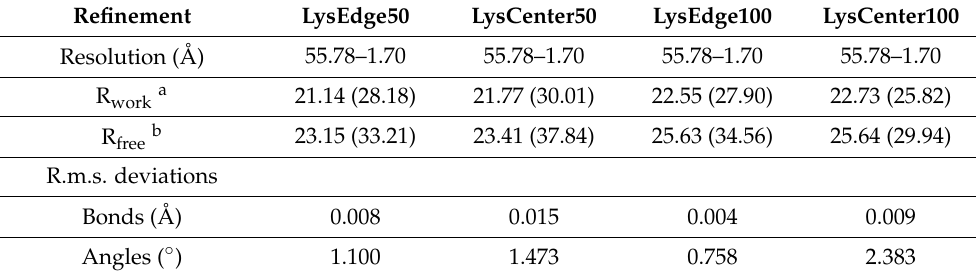
Table 2. Data refinement statistics.